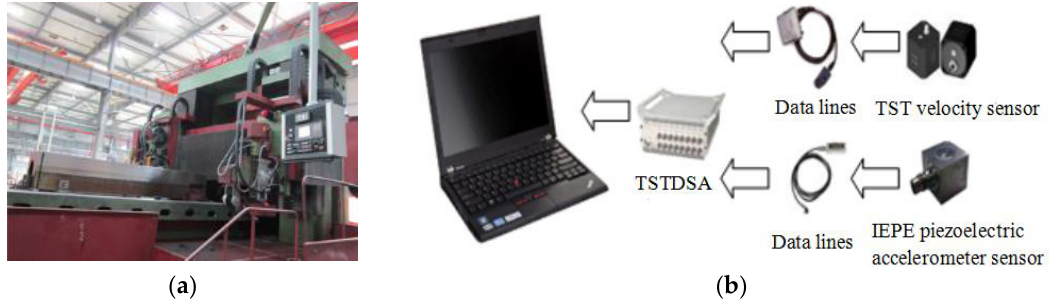
Figure 10. ( a ) Maximum and mean values of real-time variance; ( b ) maximum and mean values of instantaneous energy.